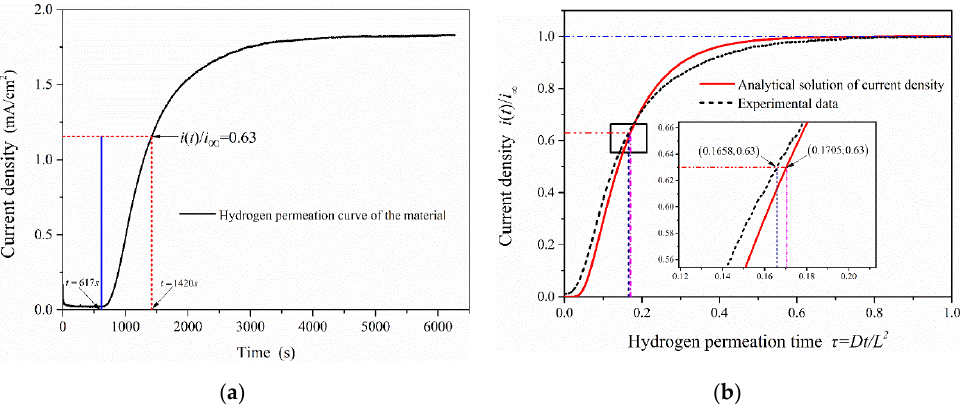
Figure 7. The change curve of oxidation current density in the process of hydrogen permeation: ( a ) Hydrogen permeation curve of 2.25Cr1Mo0.25V steel; ( b ) Comparison of test results with the analytical solutions of oxidation current density obtained under the hydrogen permeation model.